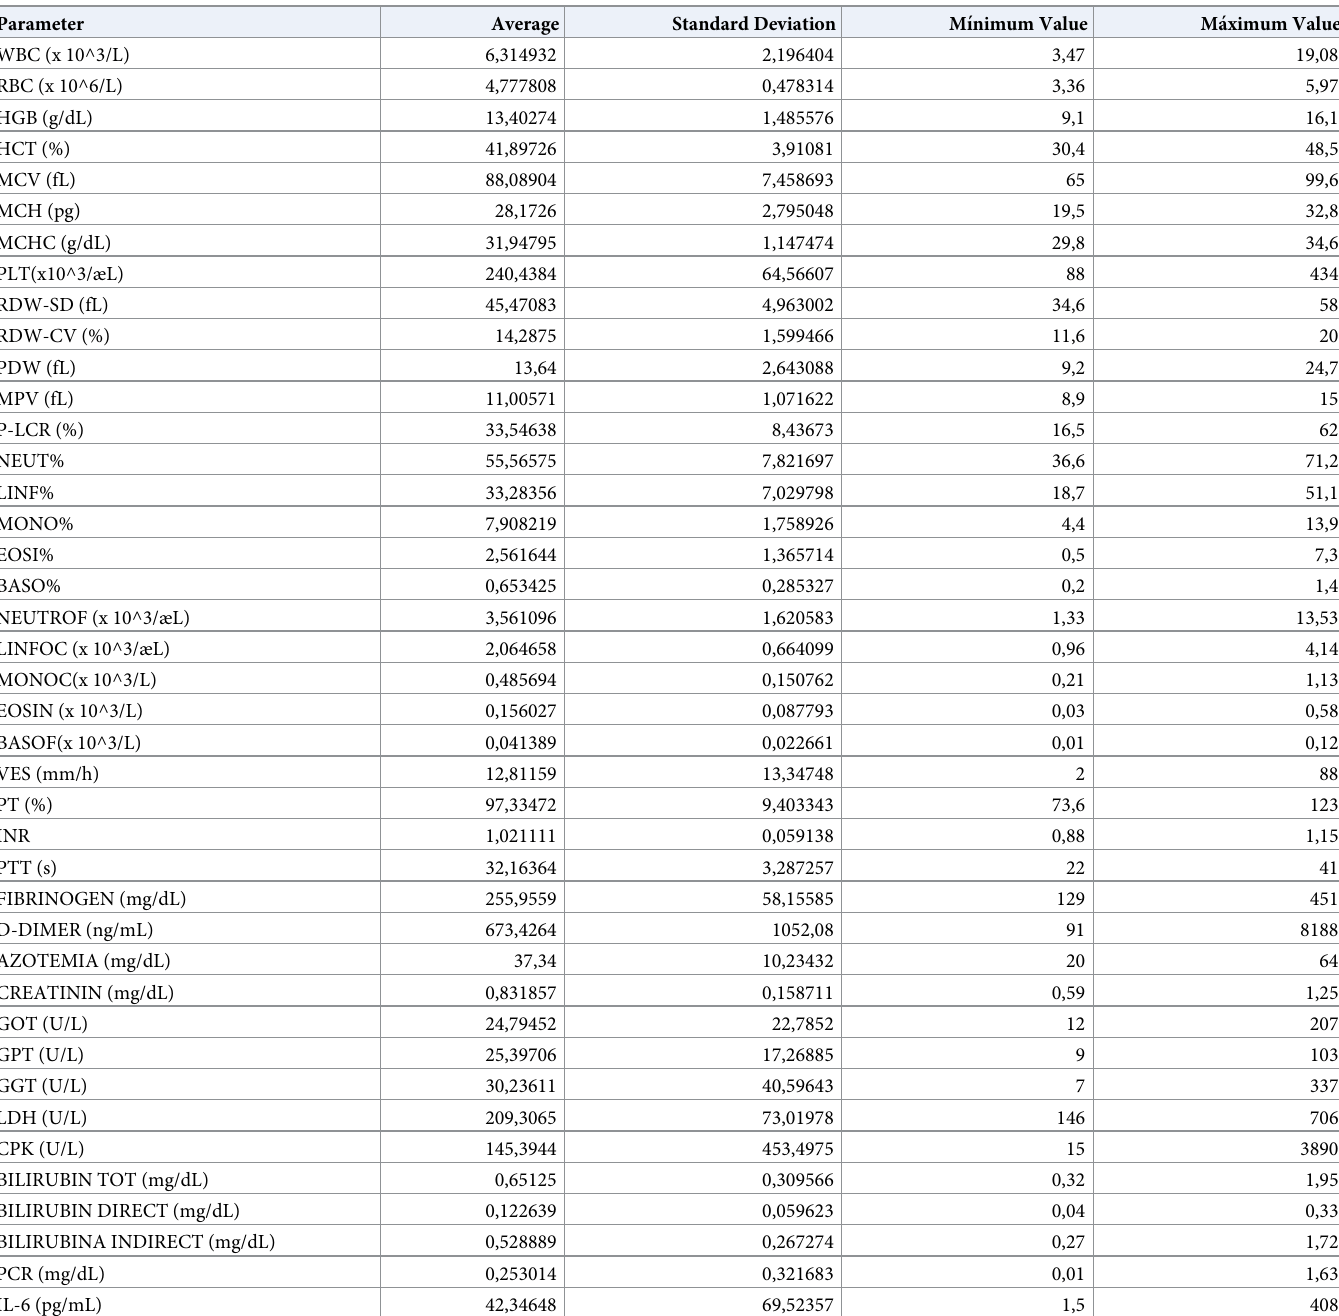
Table 3. Average values (with min/max and std deviation) of haematochemical parameters dosed at the time of hospital admission in the 75 hospitalized patients. Parameter